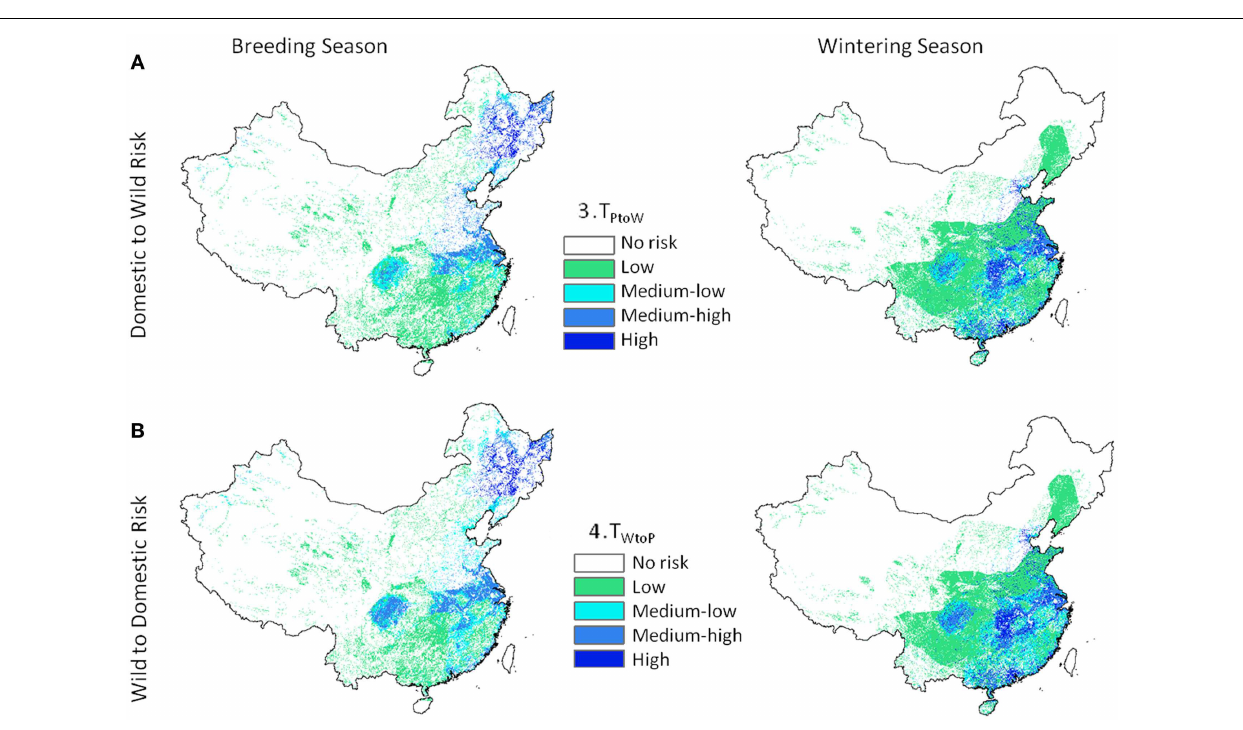
FIGURE 3 | Highly pathogenic H5N1 transmission risk between domestic poultry and wildAnatidae waterfowl at 1km resolution for China . Level 2 models include H5N1-specific transmission factors and are uni-directional with (A) representing transmission risk from domestic to wild birds (Eq. 3), and (B) from wild birds to domestic (Eq.